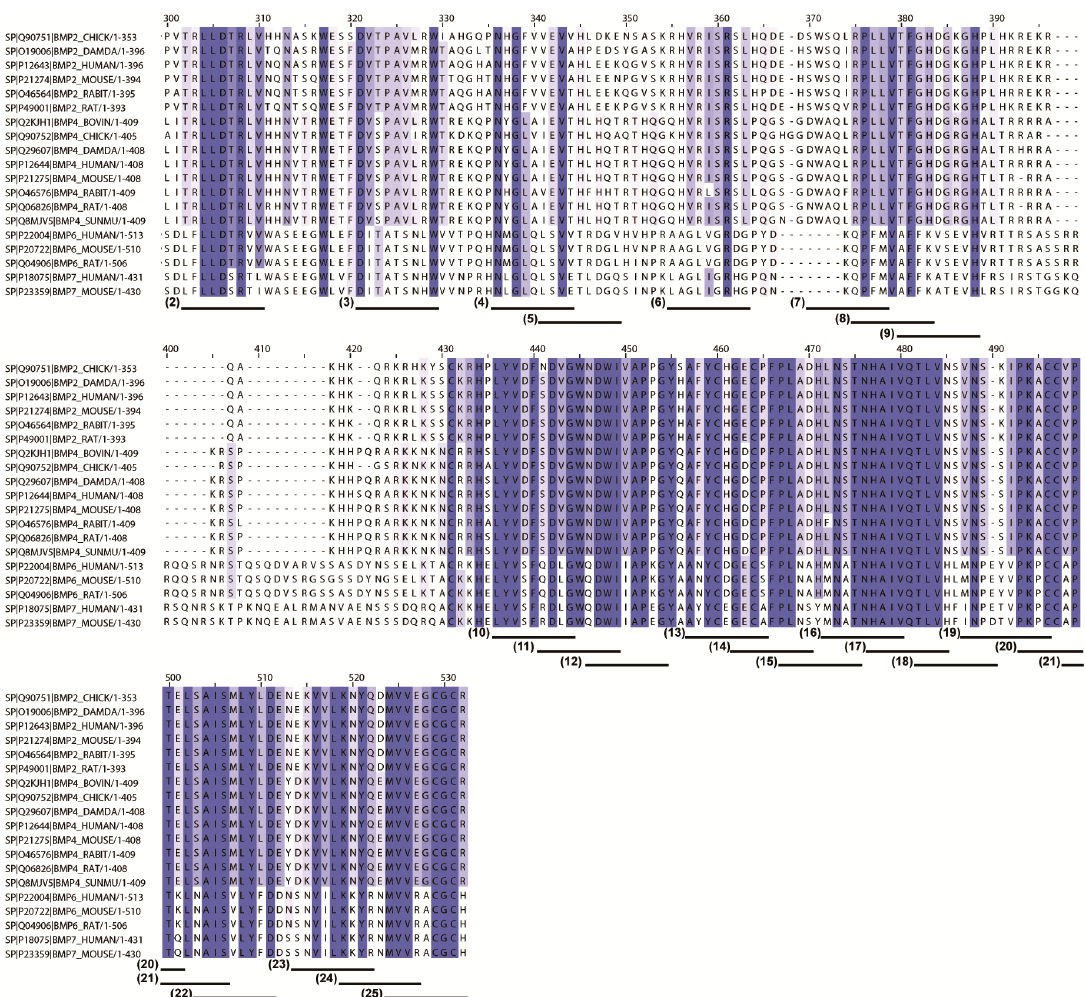
Figure 3. Homology analysis of BMP sequences for screening candidate peptides in silico. Darker blue-colored amino acids indicate high homology, and lighter blue-colored amino acids indicate low homology. Numbered underlines at the bottom of the peptide sequence alignment indicate the 25 peptide sequences selected for peptide array screening (Underlines (1) to (25)). For example, Underline (1) indicates the peptide sequence HRINIYEII (derived from BMP-2), which is listed in Table 2 as the No. 1 peptide.